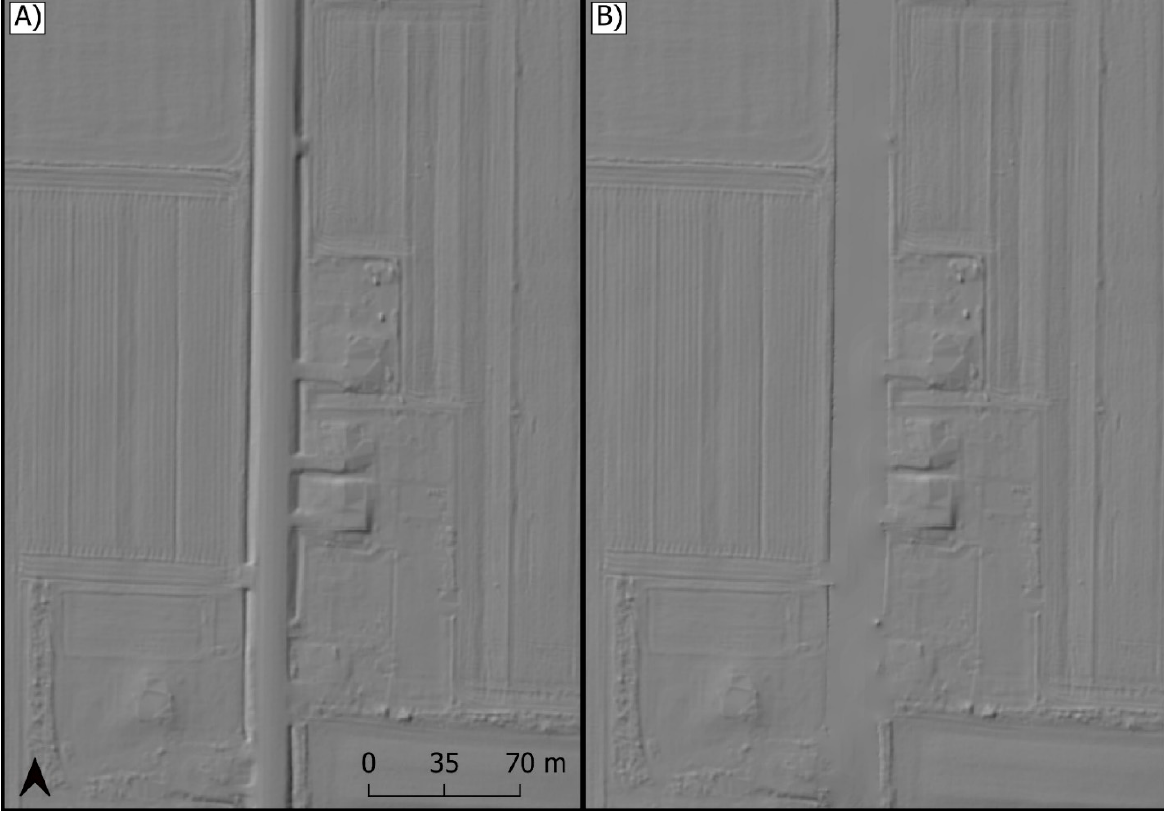
Figure 8. ( A ) A ditch-lined embankment; ( B ) The interpolated surface after the embankment was removed.